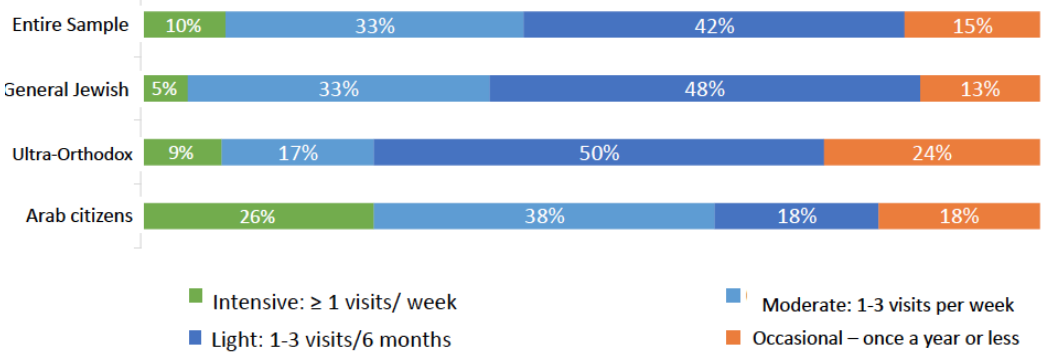
Figure 2. Frequency of visits by ethnicity.